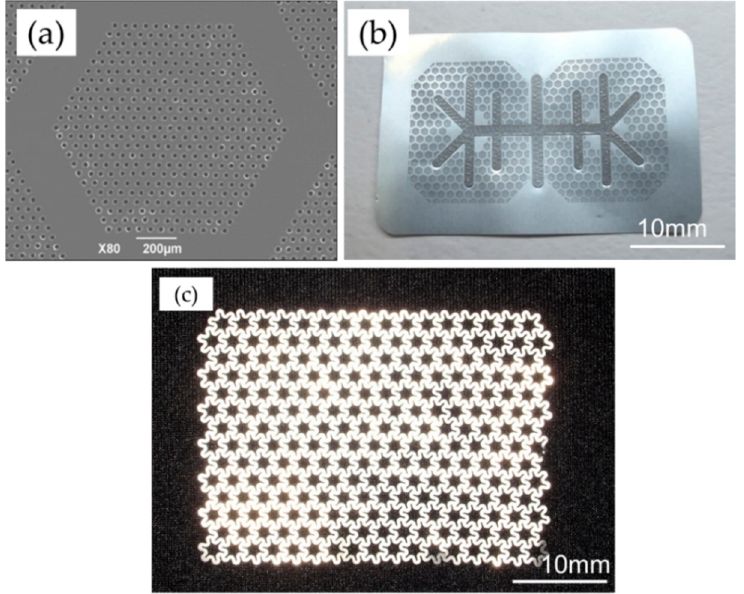
Figure 2. Membrane. ( a ) Ti-honeycomb membrane (TiHM). Pores with diameters of 20 μ m were created in a pure titanium sheet with a 20- μ m thickness, a 50- μ m pitch, within regular hexagonal compartments that had an inscribed 1.0-mm-diameter circle. These processed sections were arranged together with unprocessed, 0.2-mm-wide sections in a honeycomb shape. ( b ) TiHM (L size, 27 mm × 42 mm with a frame). A titanium reinforcement frame is jointed on the membrane. ( c ) Ultra flex mesh plate (UFMP, 35 mm × 48 mm). Star-like pores were created, and featured an inscribed, ca., 1600- µ m-diameter,